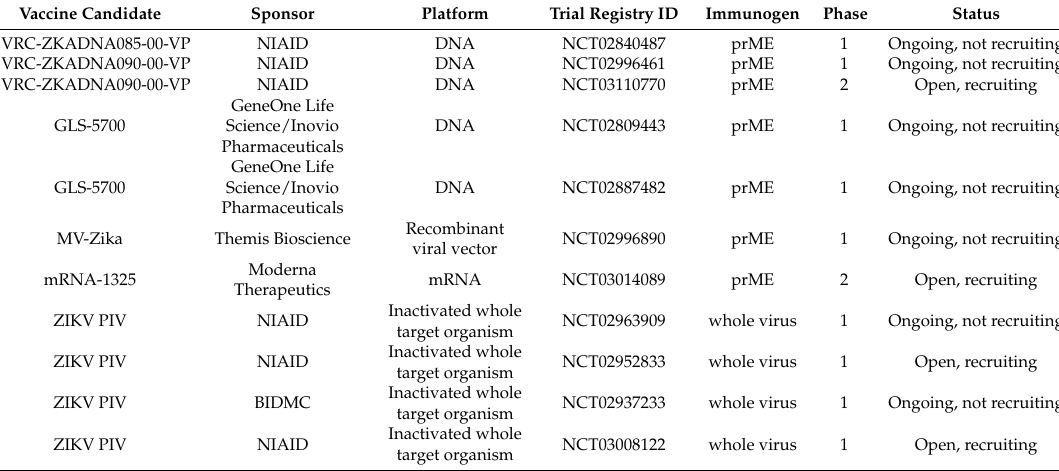
Table 1. ZIKV vaccine candidates in clinical